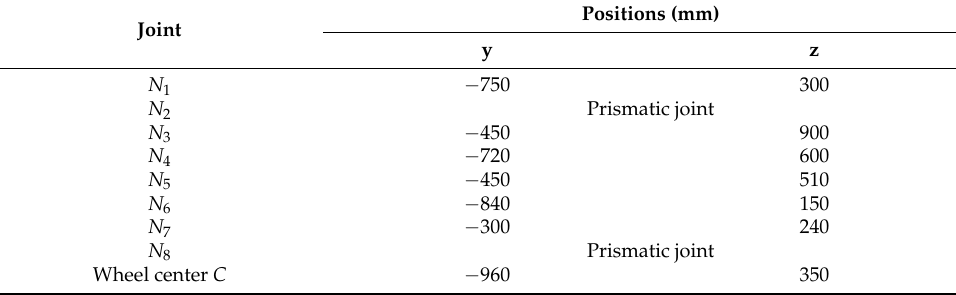
Table 2. Initial position of a planar suspension